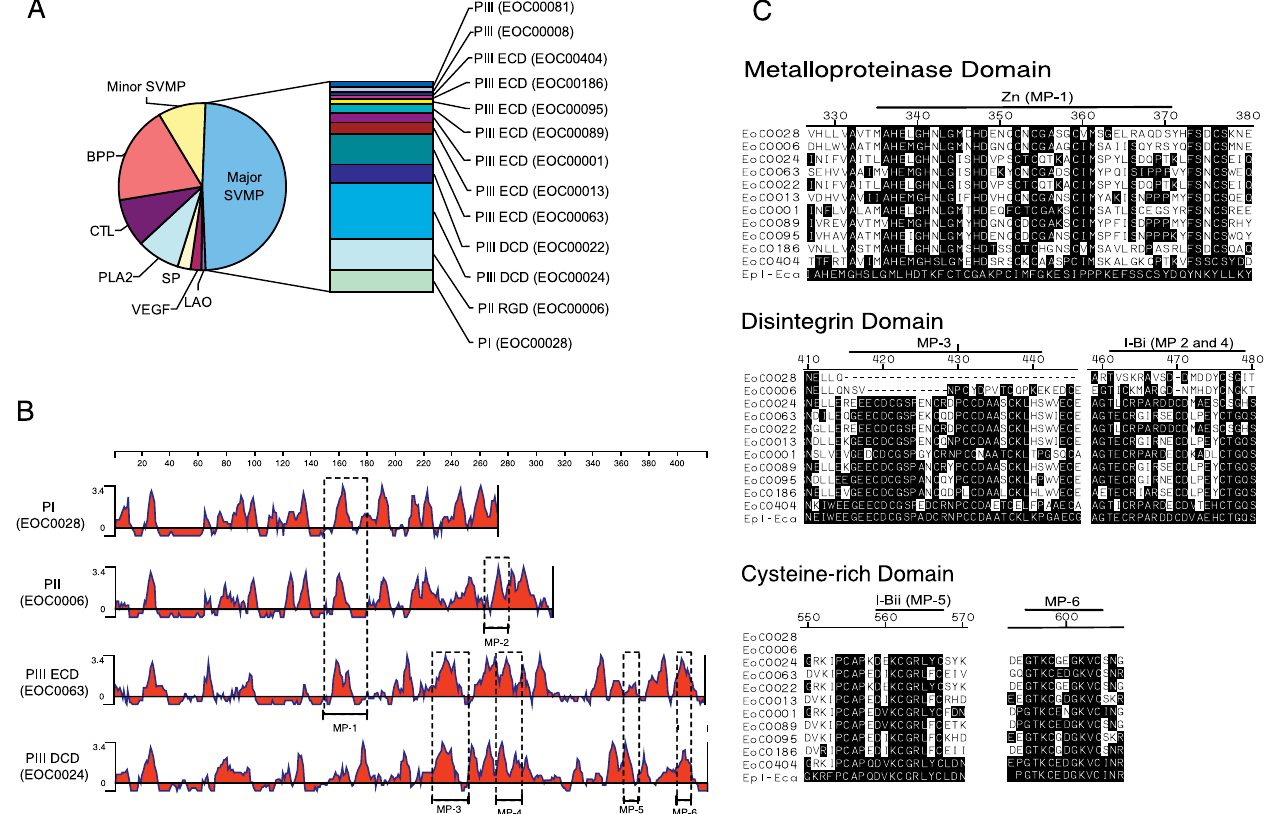
Figure 2. Identification of Conserved Domains in Snake Venom Metalloproteinases (A) Proportional representation of toxin-encoding transcripts. The proportional representation of SVMP clusters are expanded as a histogram and classified as PI–PIII isoforms. Identifiers for each cluster are indicated in parentheses. Minor SVMPs denote transcripts represented as singletons or smaller SVMP clusters (four ESTs or fewer) whose isoform class could not be reliably identified. BPP, bradykinin-potentiating peptides; CTL, C-type lectin; LAO, L-amino oxidases; PLA 2 , group II phospholipase A 2 ; SP, serine proteinases; SVMP, snake venom metalloproteinases; VEGF, vascular endothelial growth factors. (B) Comparative Jameson-Wolf antigenic profiling of representatives of the PI (EOC00028), PII (EOC00006), PIII ECD motif (EOC00063), and PIII DCD motif (EOC00024). The propeptide domain, which is proteolytically released from the zymogen [9], is excluded. Antigenic domains that show the greatest levels of sequence conservation are indicated below each transcript (MP 1–6). (C) Sequence alignment of E. ocellatus venom gland SVMP isoforms. The alignments are truncated and separated into three SVMP functional domains annotated with antigenic domains (EoMP 1–6) and motifs of functional or catalytic significance. Residues identical to ecarin (Epl–Eca [Q90495]) are shown in black for comparison. Full-length alignments are provided in Figure S1. I-Bi, integrin-targeting tripeptide motifs; I-Bii a 2 b 1 integrin-binding VKC-like motifs in jararhagin-C [46]; Zn, catalytic zinc-binding motif. DOI: 10.1371/journal.pmed.0030184.g002